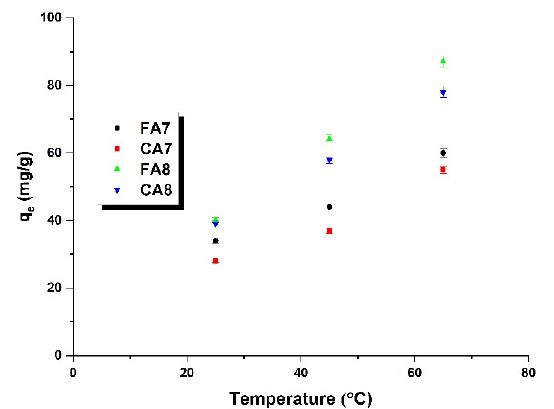
Figure 9. The temperature influence on the adsorption of methyl red sodium salt (biocarbon mass: 25 mg, concentration of initial dye solution: 40 mg/L, methyl red sodium salt solution volume: 50 mL). Table 6. Thermodynamic